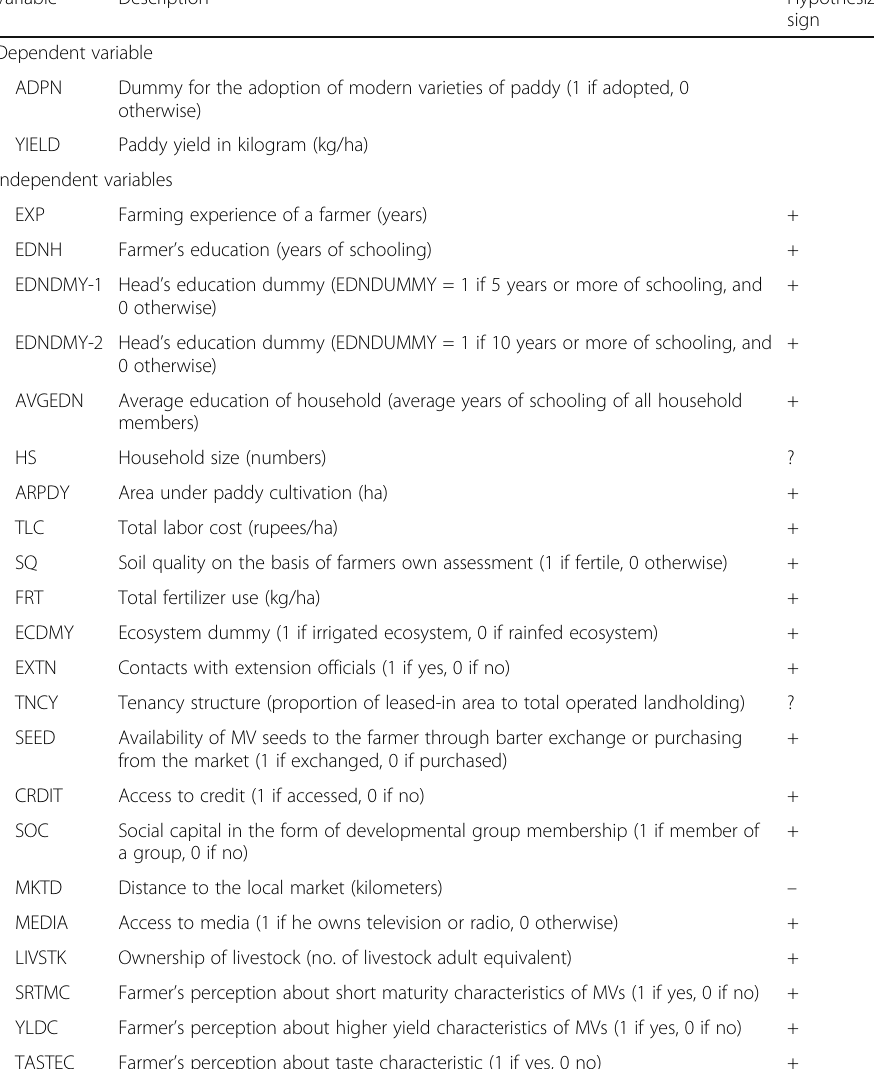
Table 1 Definition of variables and hypotheses Variable Description Hypothesized